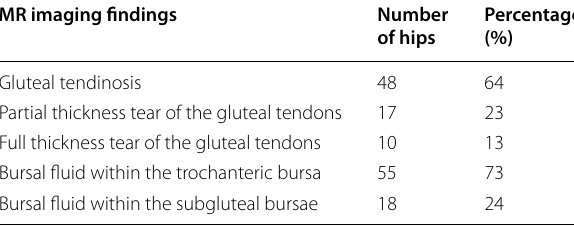
Table 2 MRI findings in this study MR imaging